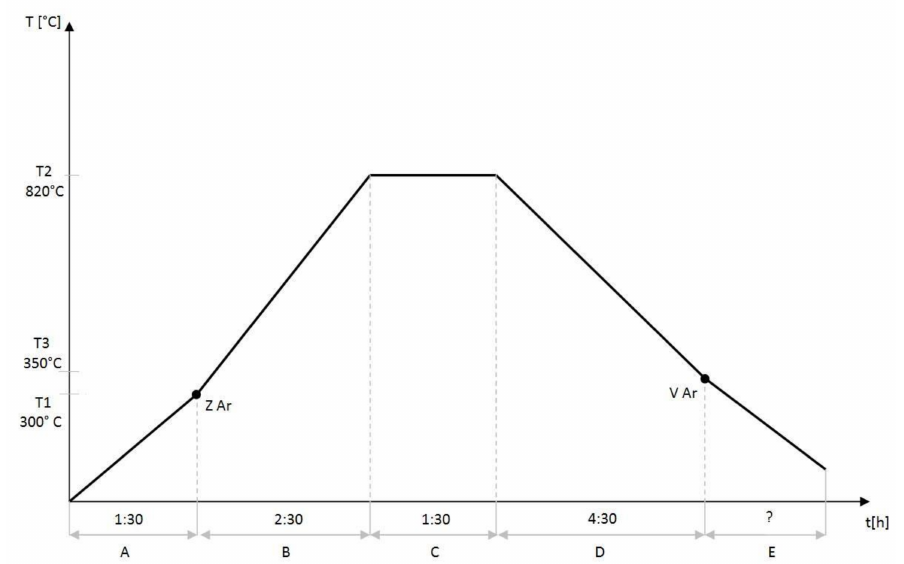
Figure 4. Heat treatment curve of titanium